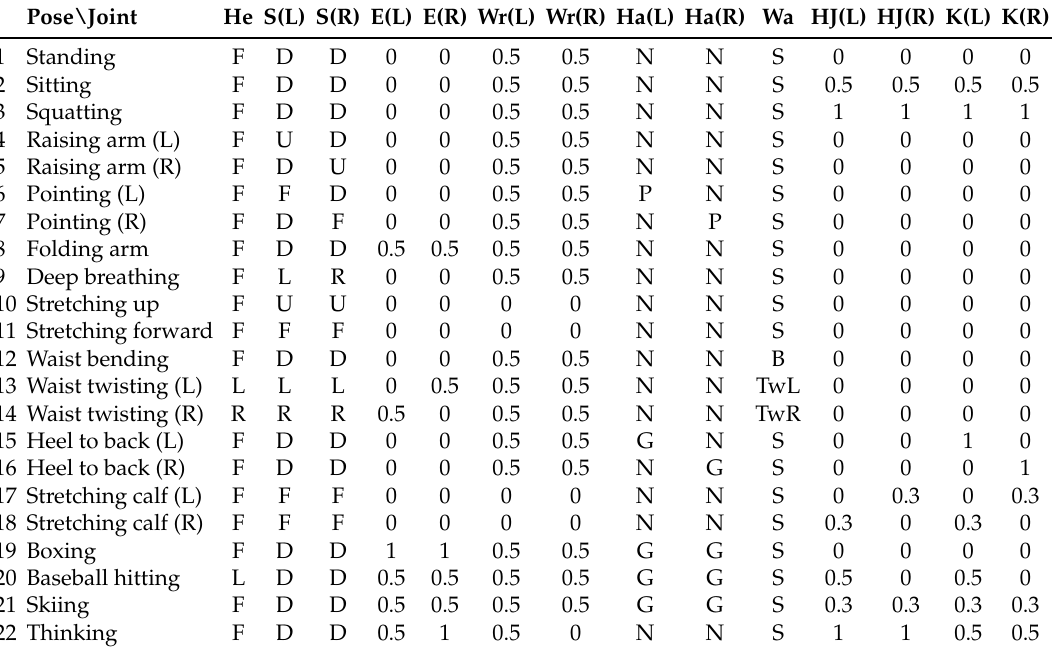
Table 3. Definition of the poses in HDPoseDS. (L) denotes left part and (R) denotes right part. For joints, He: Head, S: Shoulder, E: Elbow, Wr: Wrist, Ha: Hand, Wa: Waist, HJ: Hip Joint, K: Knee. For joint status, F: Front, U: Up, D: Down, L: Left, R: Right, N: Normal, G: Grasp, P: Pointing, S: Straight, B: Bend, TwL (R): Twist to Left